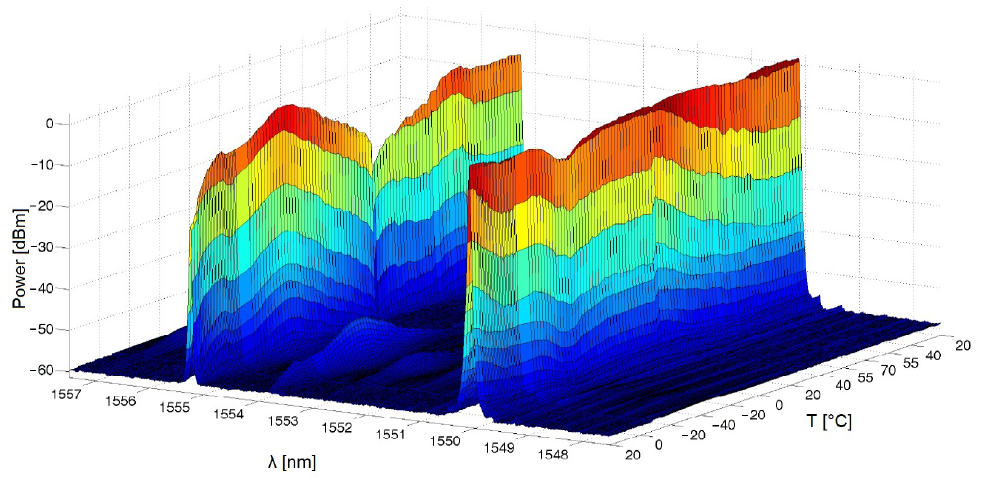
Figure 4. Power dependence on temperature in both polarization planes.